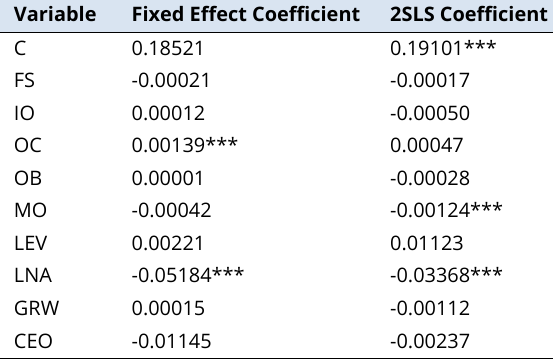
Fixed Effect and 2SLS Regression of Foreign Shareholdings and